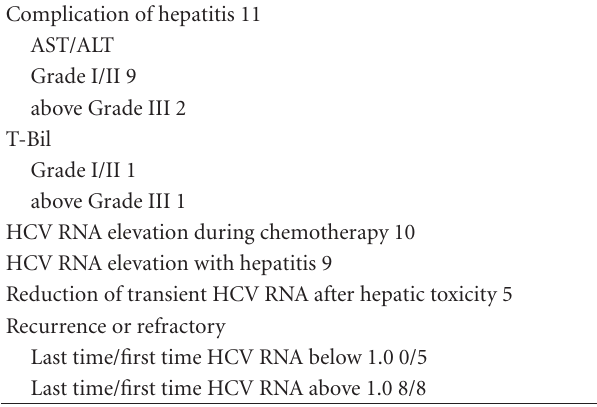
Table 2: Tendency of the anti-HCV-antibody-positive